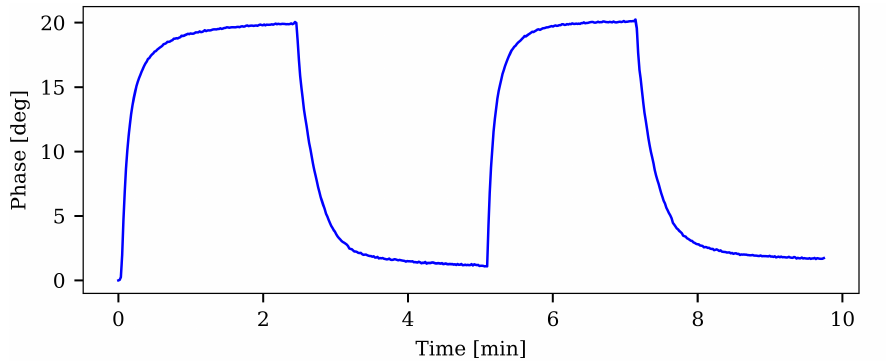
Figure 12. The results of the step-response measurements. The POF sensor underwent two cycles in which it was moved from low oxygen of 0–2% (low phase) to high oxygen of 98–100% (high phase). The t 95 response-time averaged at 48s when going from low-oxygen to high-oxygen, and 57s for the high-to-low